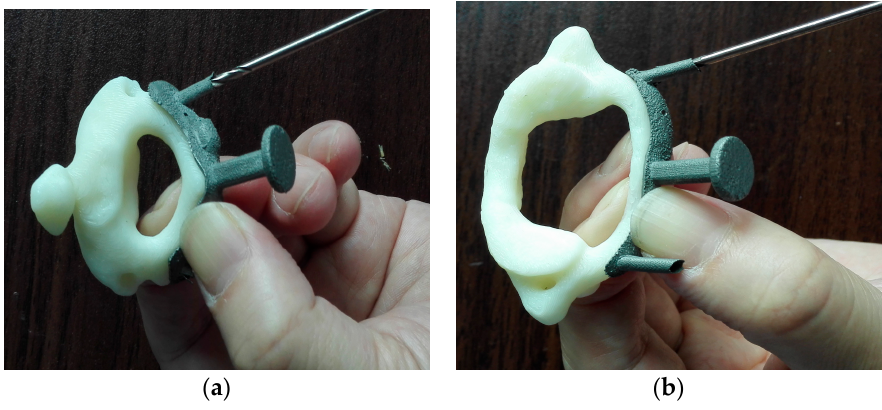
Figure 9. In vitro test of the metal templates. ( a ) Axis template; ( b ) atlas template.